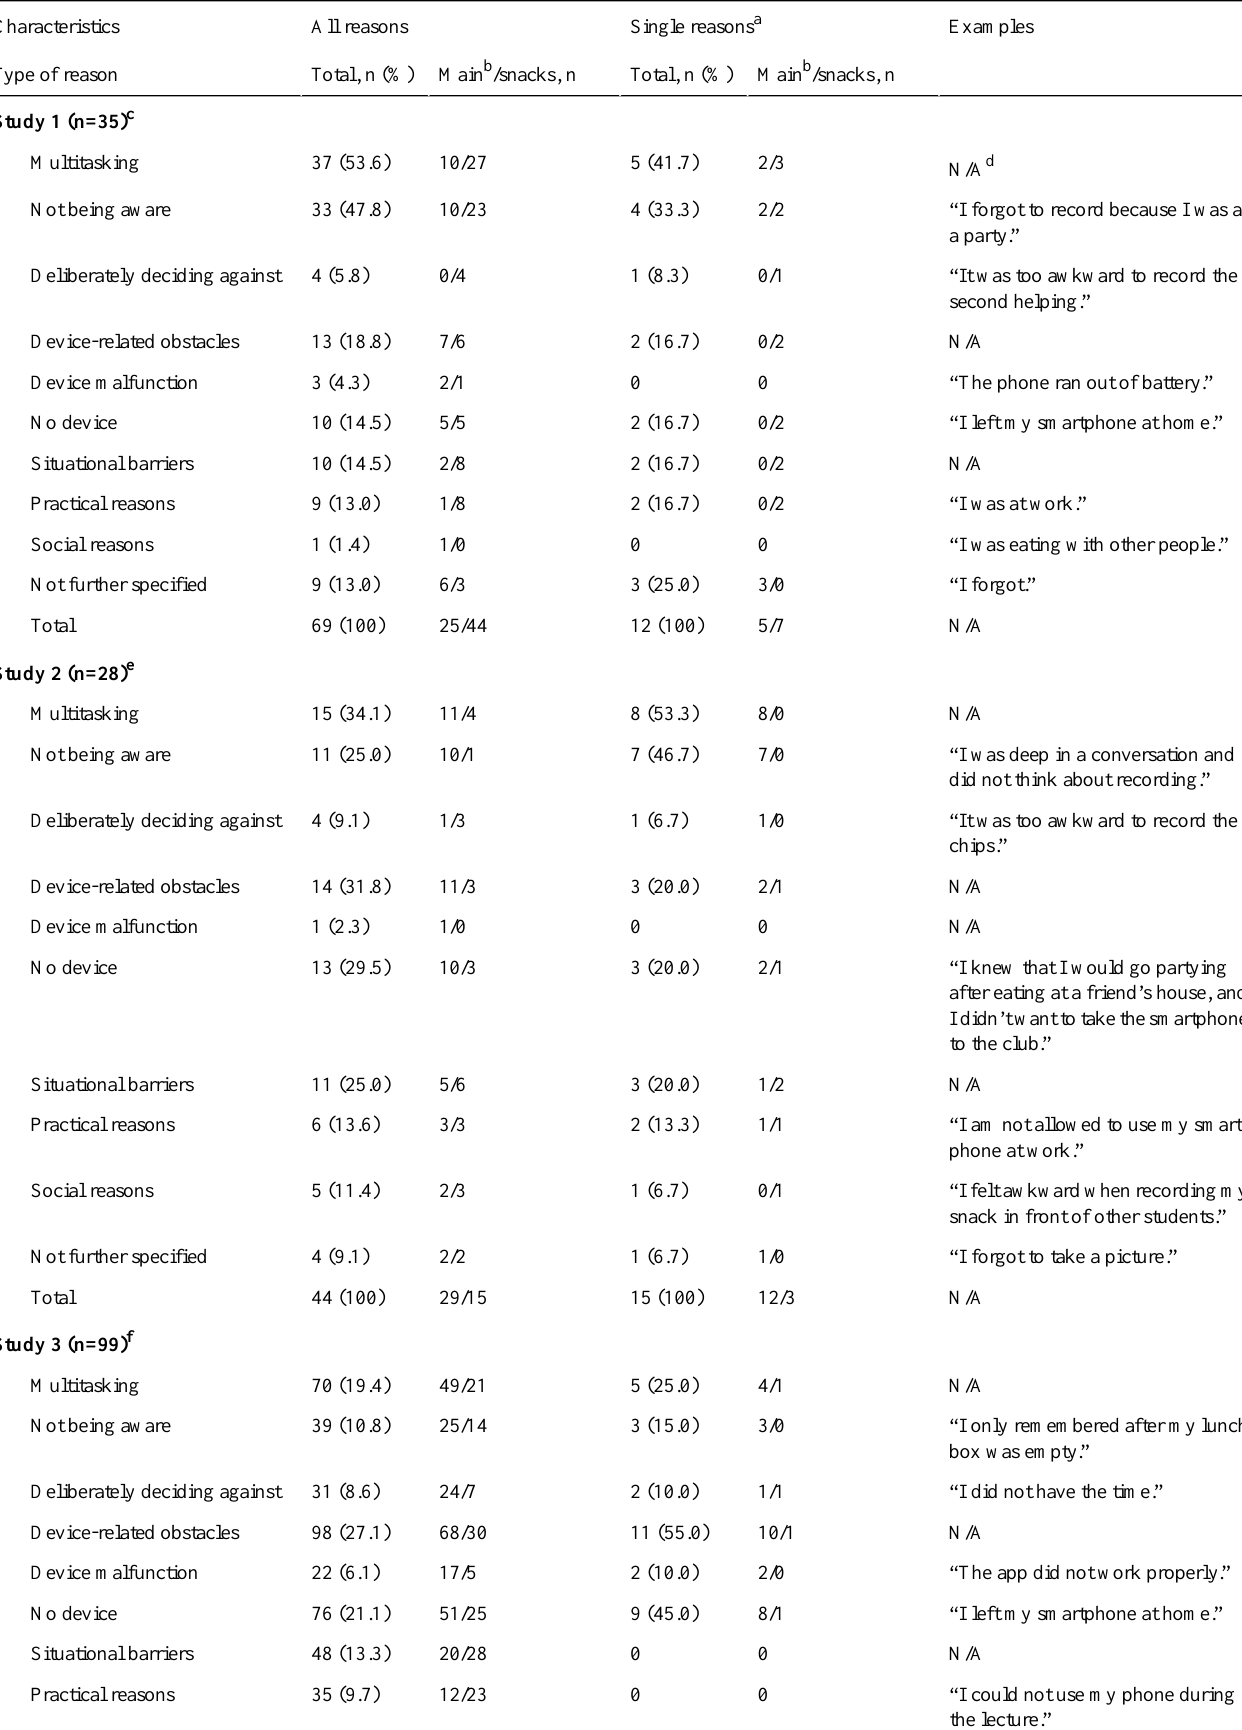
Table 3. Type and number of reported reasons for perceived missing events for studies 1, 2, and 3.